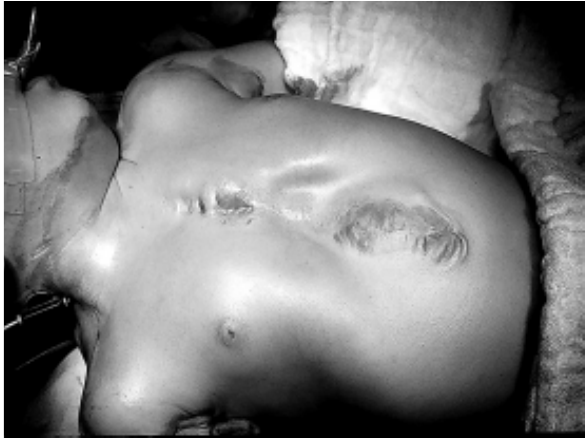
Fig. 1 – Deiscência mecânica na região esternal e hérnia abdominal.